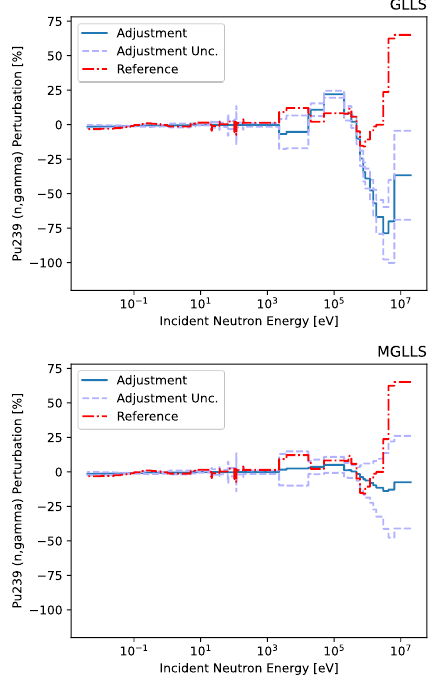
Fig. 4 Comparison of adjusted nuclear data #3